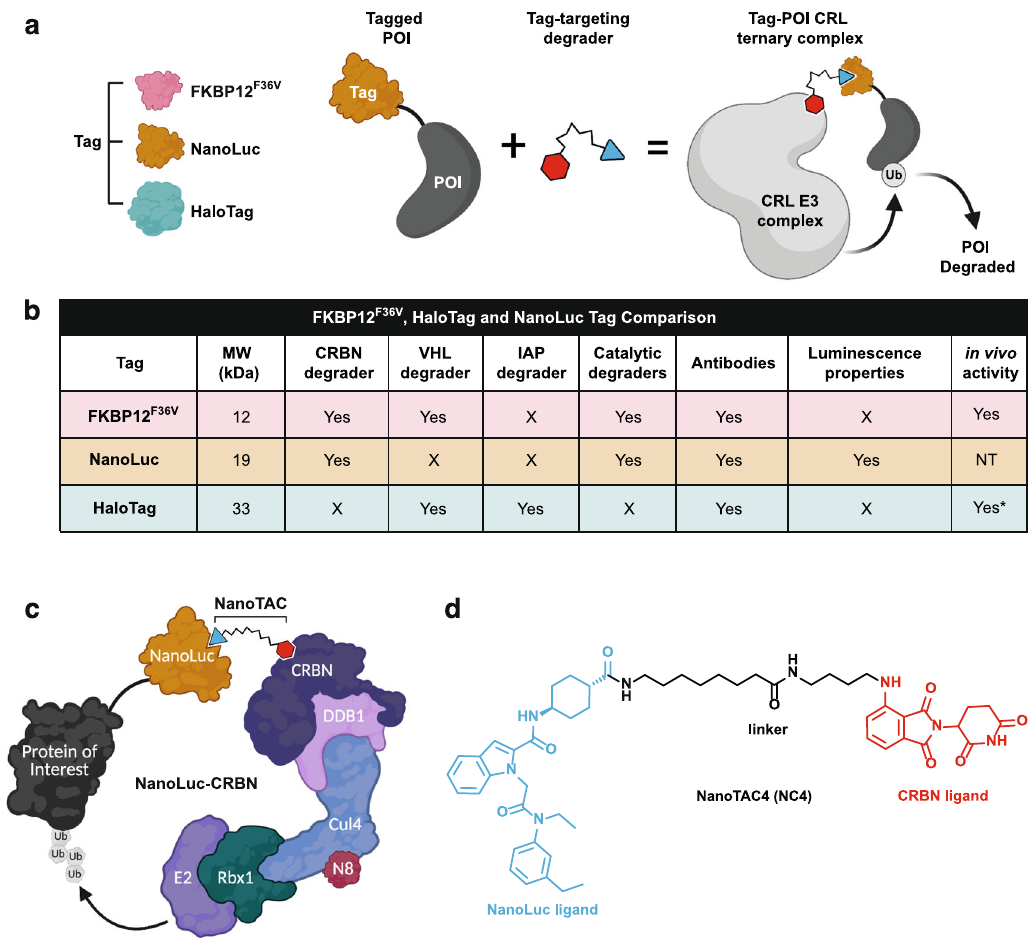
Fig. 1 Development of NanoTACs; a NanoLuc-targeting degrader system. a Schematic depicting the tTPD systems. FKBP12 F36V , NanoLuc or Halo epitope tags are fused to proteins of interest (POI) and tag-targeting heterobifunctional degrader compounds are employed to hijack cullin-RING ligase (CRL) complexes to trigger proteasomal degradation of the tagged POI. b Comparison of tools and properties of each tag for tag-targeted protein degradation. NT not tested. Asterisk (*) see discussion for further information. c Schematic depicting the NanoLuc-CRBN tTPD system. d Chemical structure of the